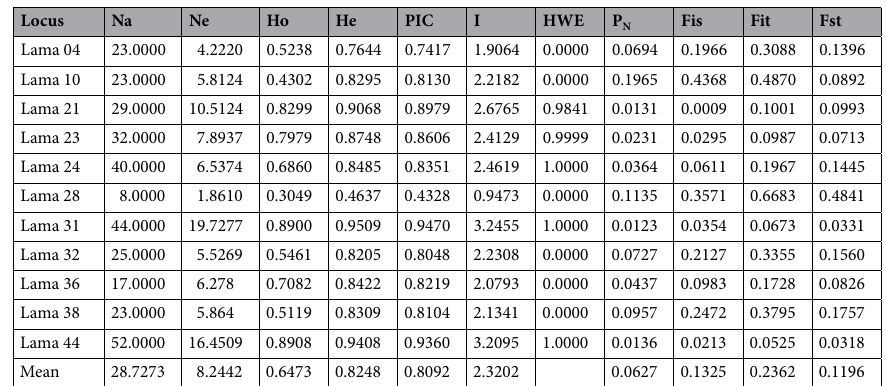
Table 1. Genetic diversity of 11 microsatellite loci in eight L. maculatus populations. Na observed number of alleles, Ne expected number of alleles, Ho observed heterozygosity, He expected heterozygosity, PIC polymorphic information content, I shannon wiener index, HWE deviations from Hardy–Weinberg equilibrium, P N frequency of null alleles, Fis inbreeding coefficient, Fit total in-coefficient of population.